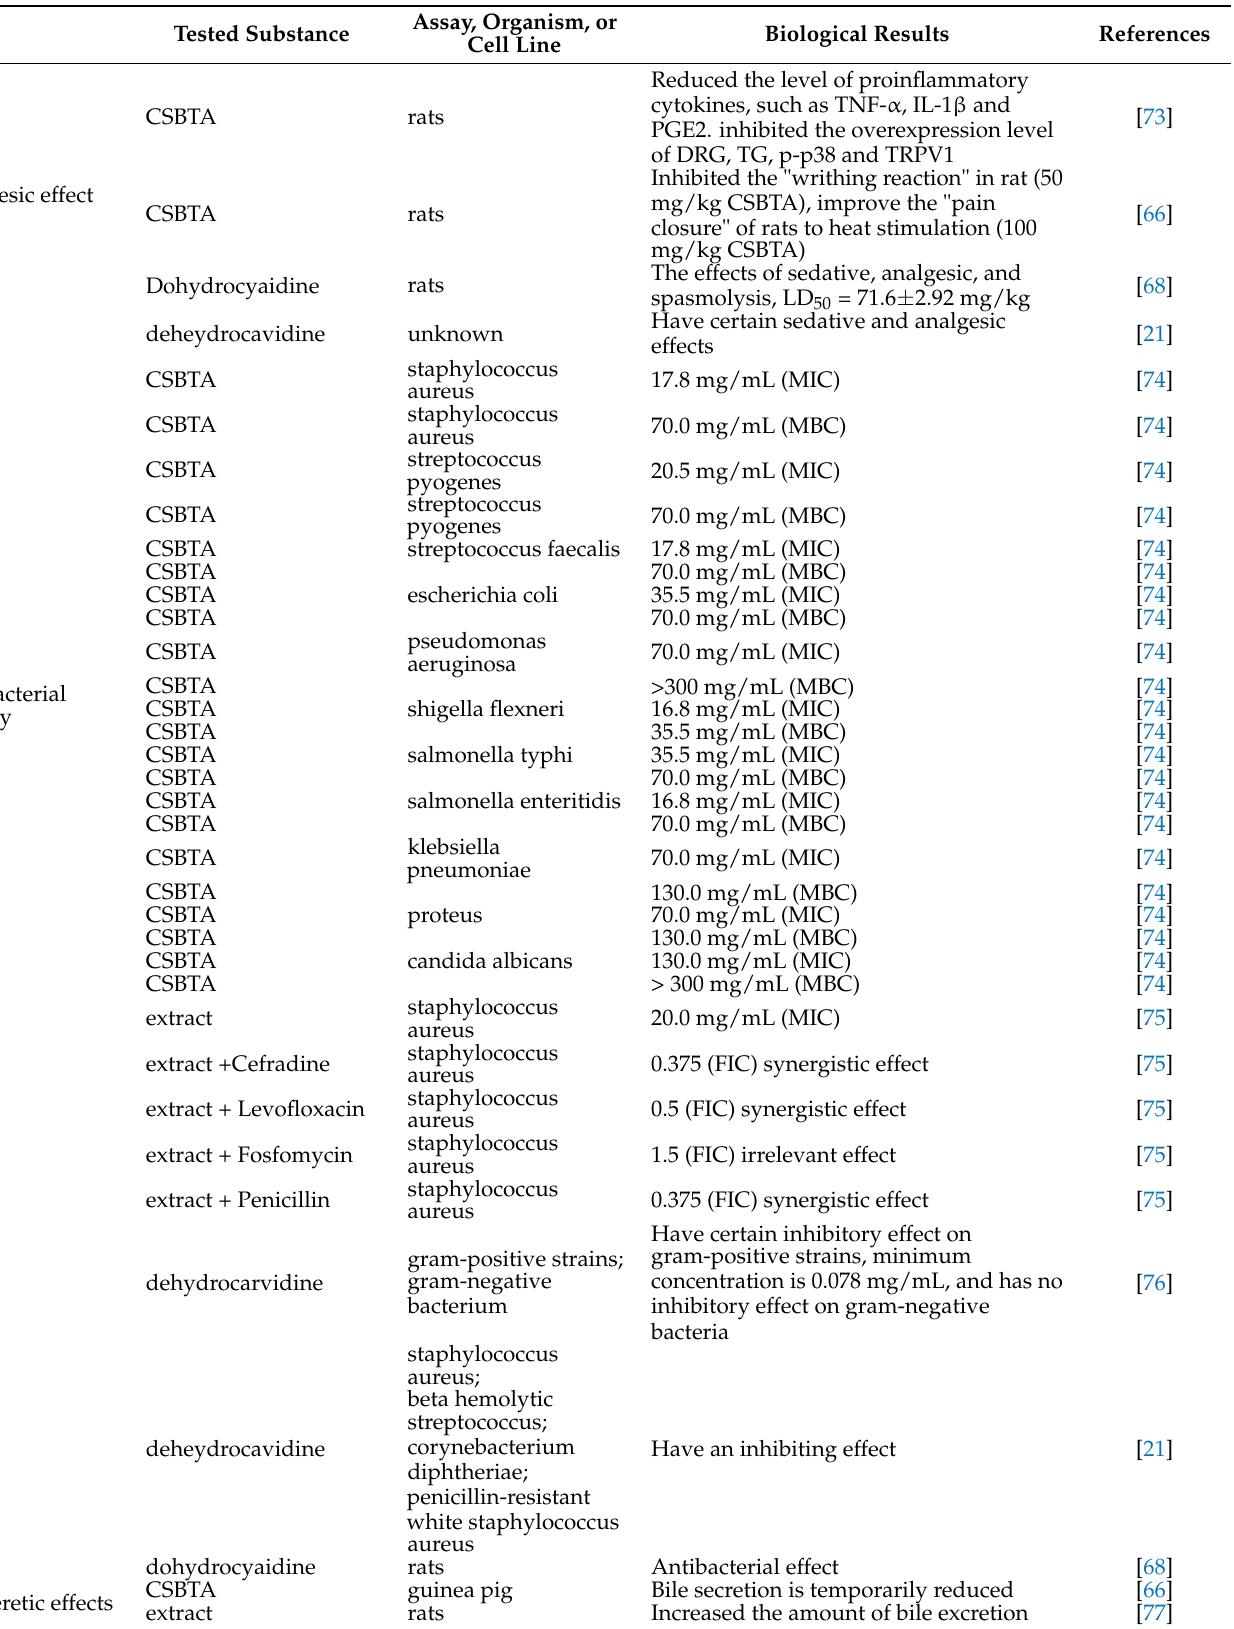
Table 2. Cont. Tested Substance